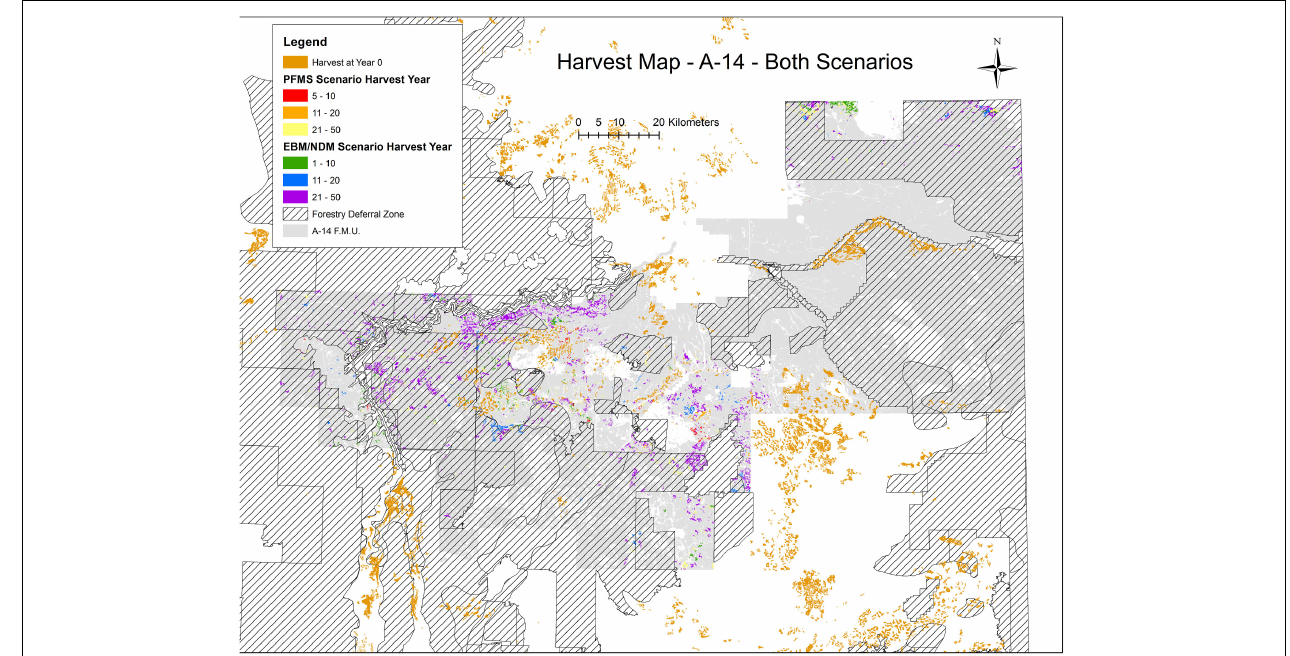
FIGURE 2 | Locations of existing harvested stands in Year 0 (start of simulation = 2016) and simulated harvested stands accumulated over 50 years under both the PFM and EBM scenarios in one of the Al-Pac forest management units (A-14), along with the locations of caribou conservation zones where harvest was deferred in the first 20 years of the PFM scenario. Existing harvest areas (brown) already present in A-14 at Year 0 could occur within the deferral zones as could harvests from the first 20 years of the EBM scenario (green, blue), but harvests from the first 20 years of the PFM scenario (red, orange) were excluded from the deferral zone. From Year 20 to Year 50, harvests under both scenarios could occur inside or outside the deferral zones and often the same harvest locations were selected under either scenario. Harvest over 50 years comprised a very small percentage of FMUs under either scenario, and overall forest age increased under both